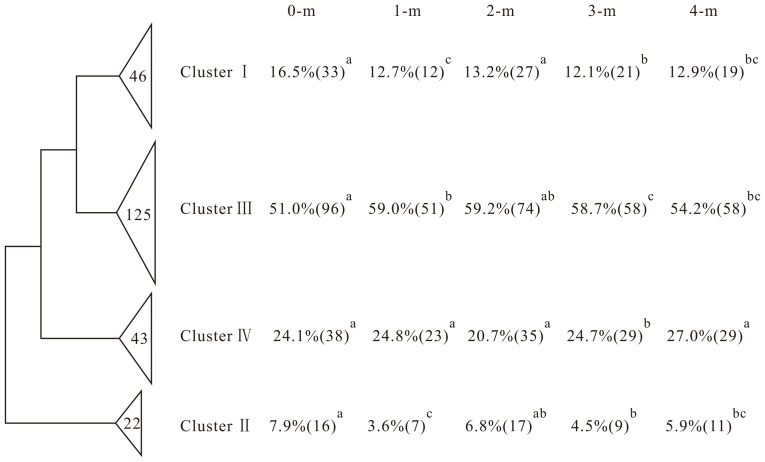
Maximum-likelihood phylogenetic tree of the 236 different nifH gene sequences obtained from GeoChip 3.0 analysis.The width of each wedge is the number of nifH sequences within each cluster. The percentages and numbers in each bracket are the signal proportions and detected gene numbers of each cluster within each depth, respectively. The significant differences of gene abundance were analyzed by one-way ANOVA.